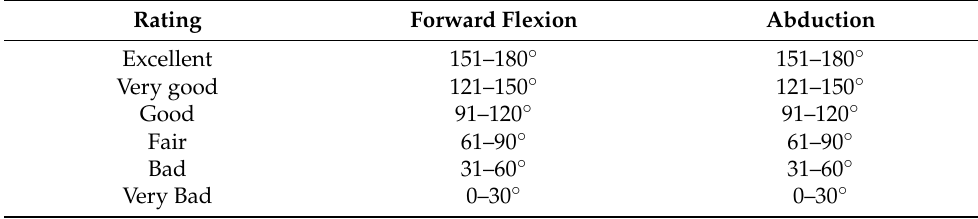
Table 1. Rating system for the range of motion based on the Constant Score